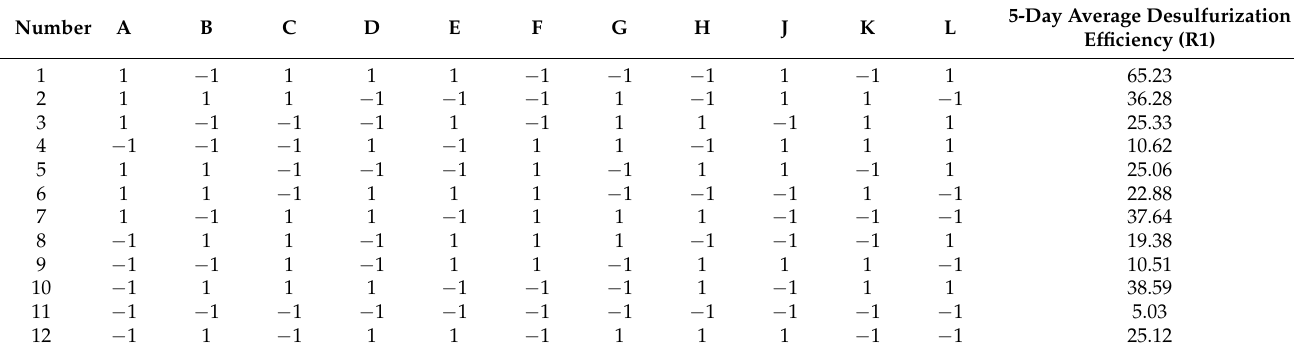
Table 2. Design matrix for desulfurization factors and corresponding responses from the